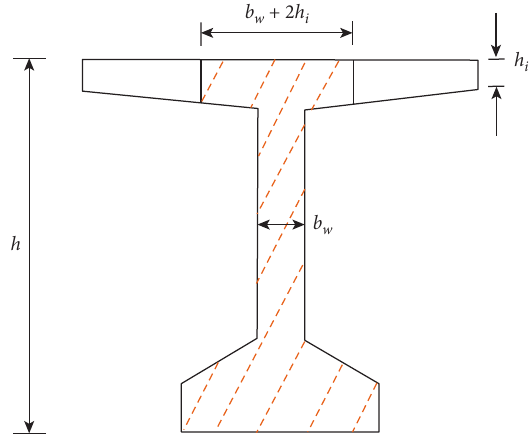
Figure 7: Shear section of the T-shaped